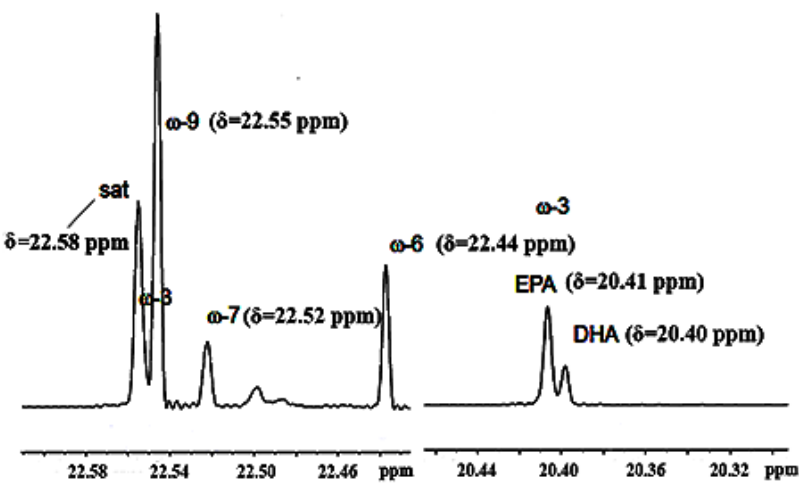
Figure 11. 13 C-NMR chemical shifts of the methylene C-2 carbons allow the identification of the EPA and DHA ω-3 fatty acids. Free download from: http://www.ilps.org/index.php/Standardized_Methods.html.